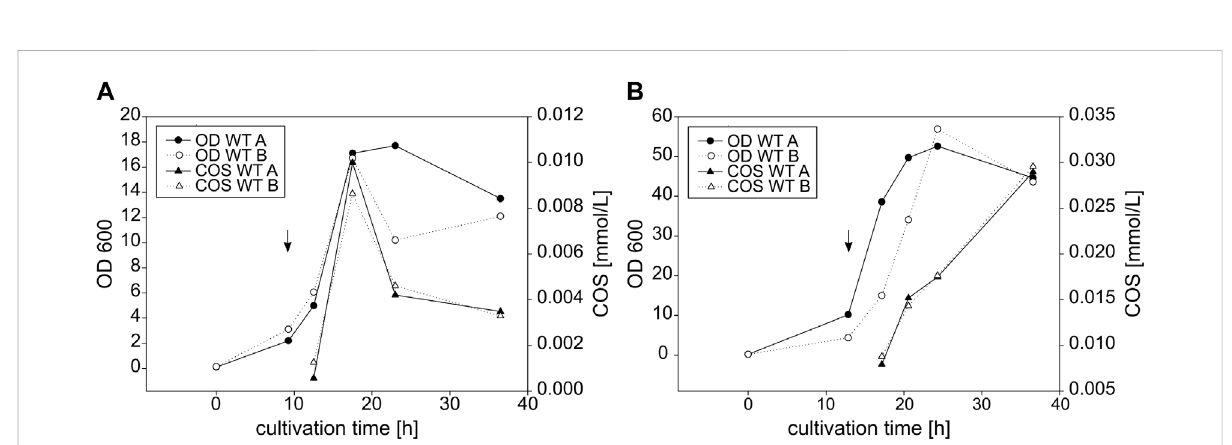
FIGURE 8 Growth and COS yield of E coli (A) and C. glutamicum (B) expressing wildtype NodC_GRH2. Shown is the growth represented by the OD600 and the development of the total COS concentration [mmol/L] over the cultivation time [h]. Depicted as an example are two wildtype cultivations per expression host with the induction indicated by an